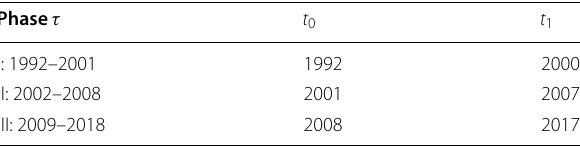
Table 10 Comparison